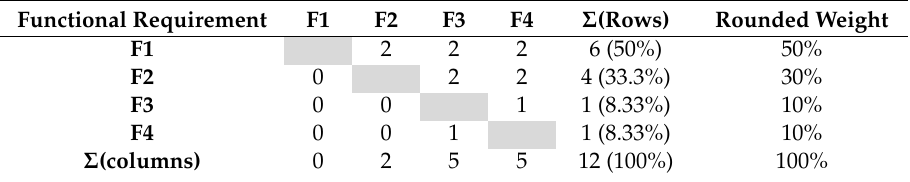
Table 1. Application of weighting mechanism for functional requirements adopting round-robin table and ternary logic scale. (0) Column is perceived as more important than row. (1) Column and row are equally important. (2) Row is perceived more important than